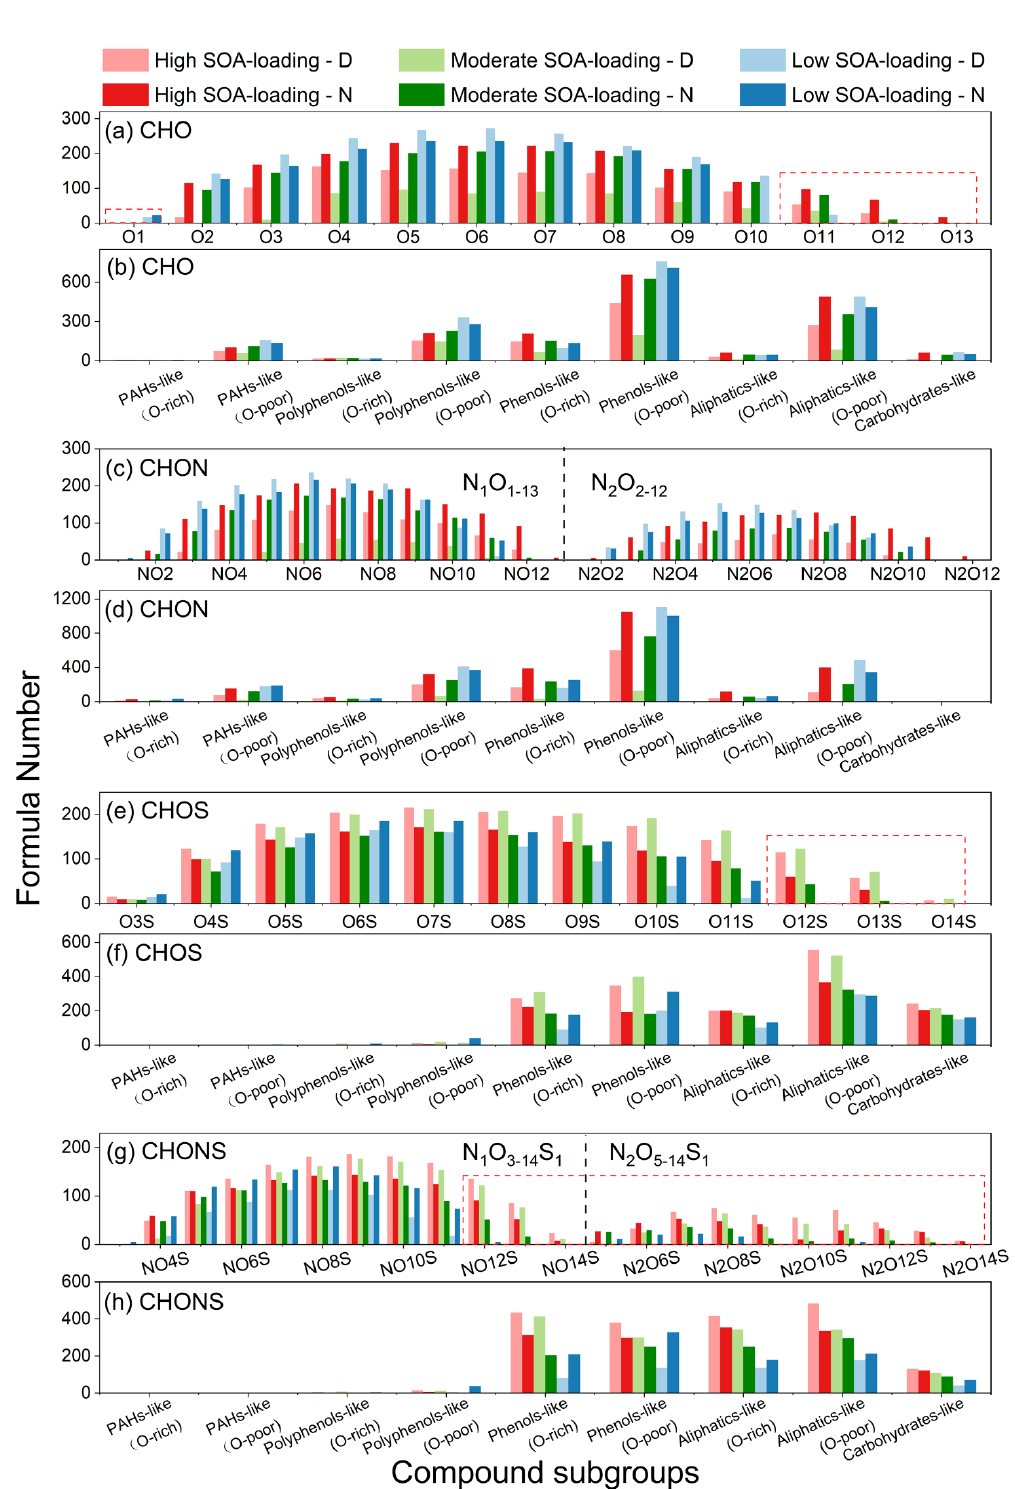
Figure 4. (a, c, e, g) Classification of CHO, CHON, CHOS, and CHONS compounds into different subgroups based on the number of O and N atoms in molecules. (b, d, f, h) The number of five compound classifications of all molecules to each sample. The column is the sum of the formula number in each